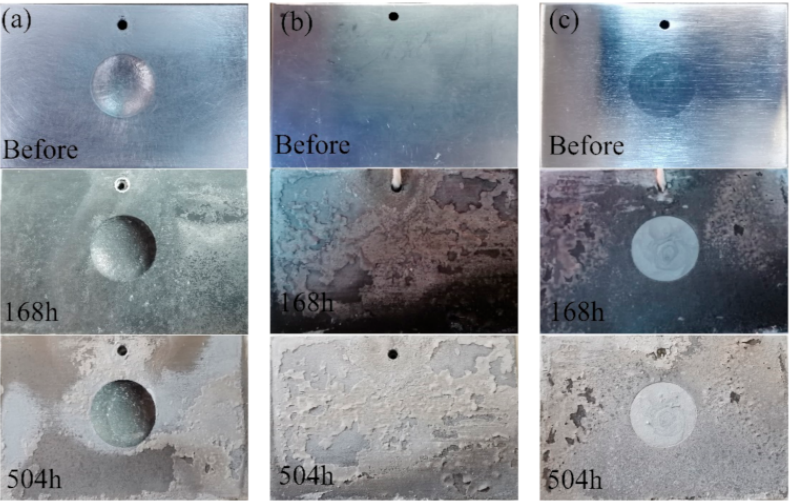
Figure 8. Surface appearances of ( a ) the UR samples, ( b ) 7N01-T4, and ( c ) the CS samples after alternate immersion